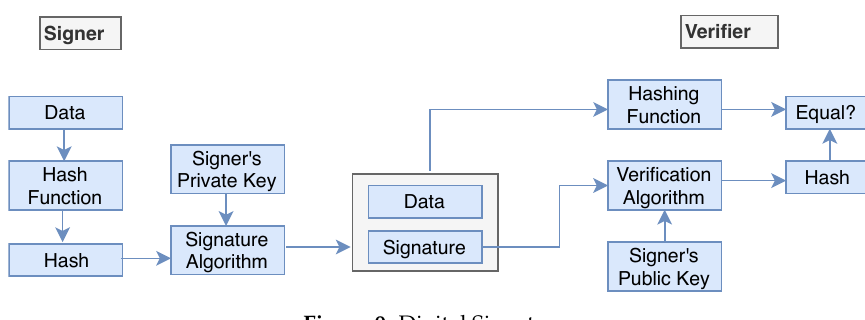
Figure 9. Digital